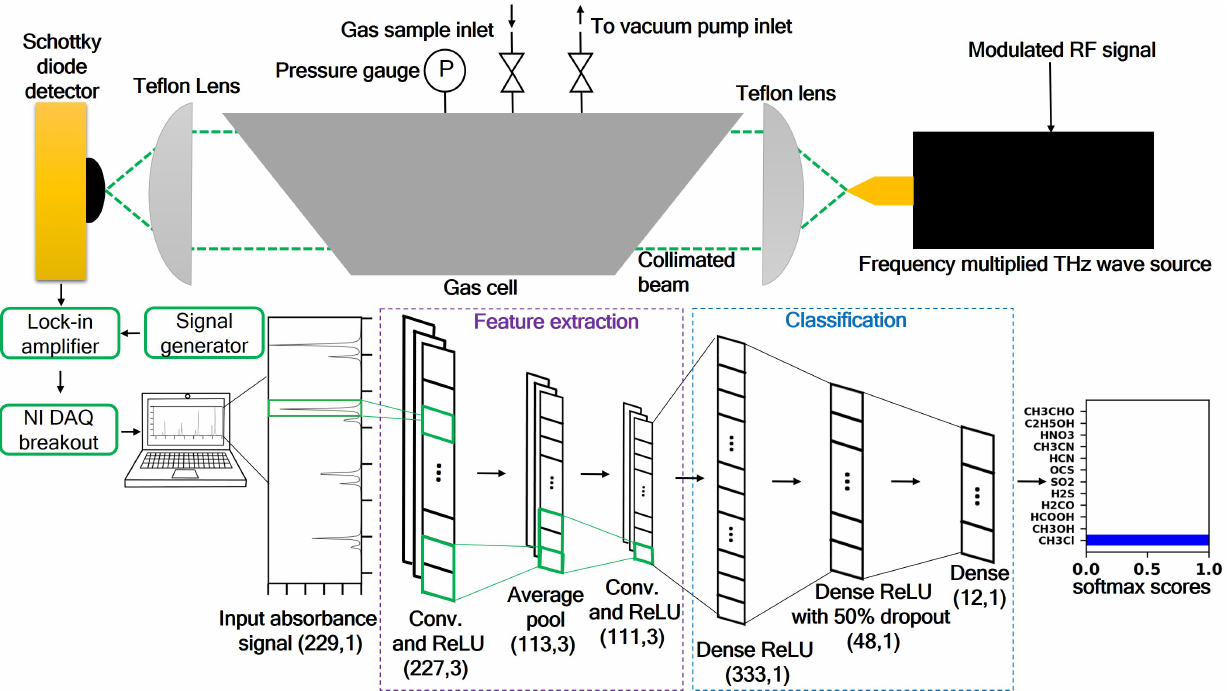
Figure 1. VOC-Net model for the automated classification of absorption spectra measured with a THz